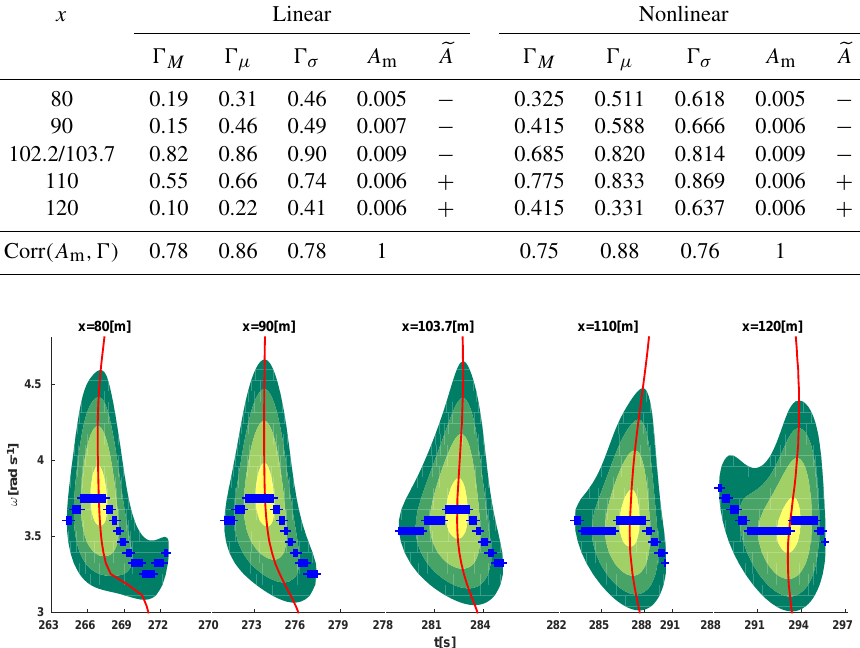
Figure 25. Case IW12. A filled contour plot of the energy distribution of the group event at various positions. At each position, the red solid lines show the time of maximal energy at each wave frequency. The ++ lines show the wave frequency as function of time. Both are estimated by the most energetic waves in time and frequency,